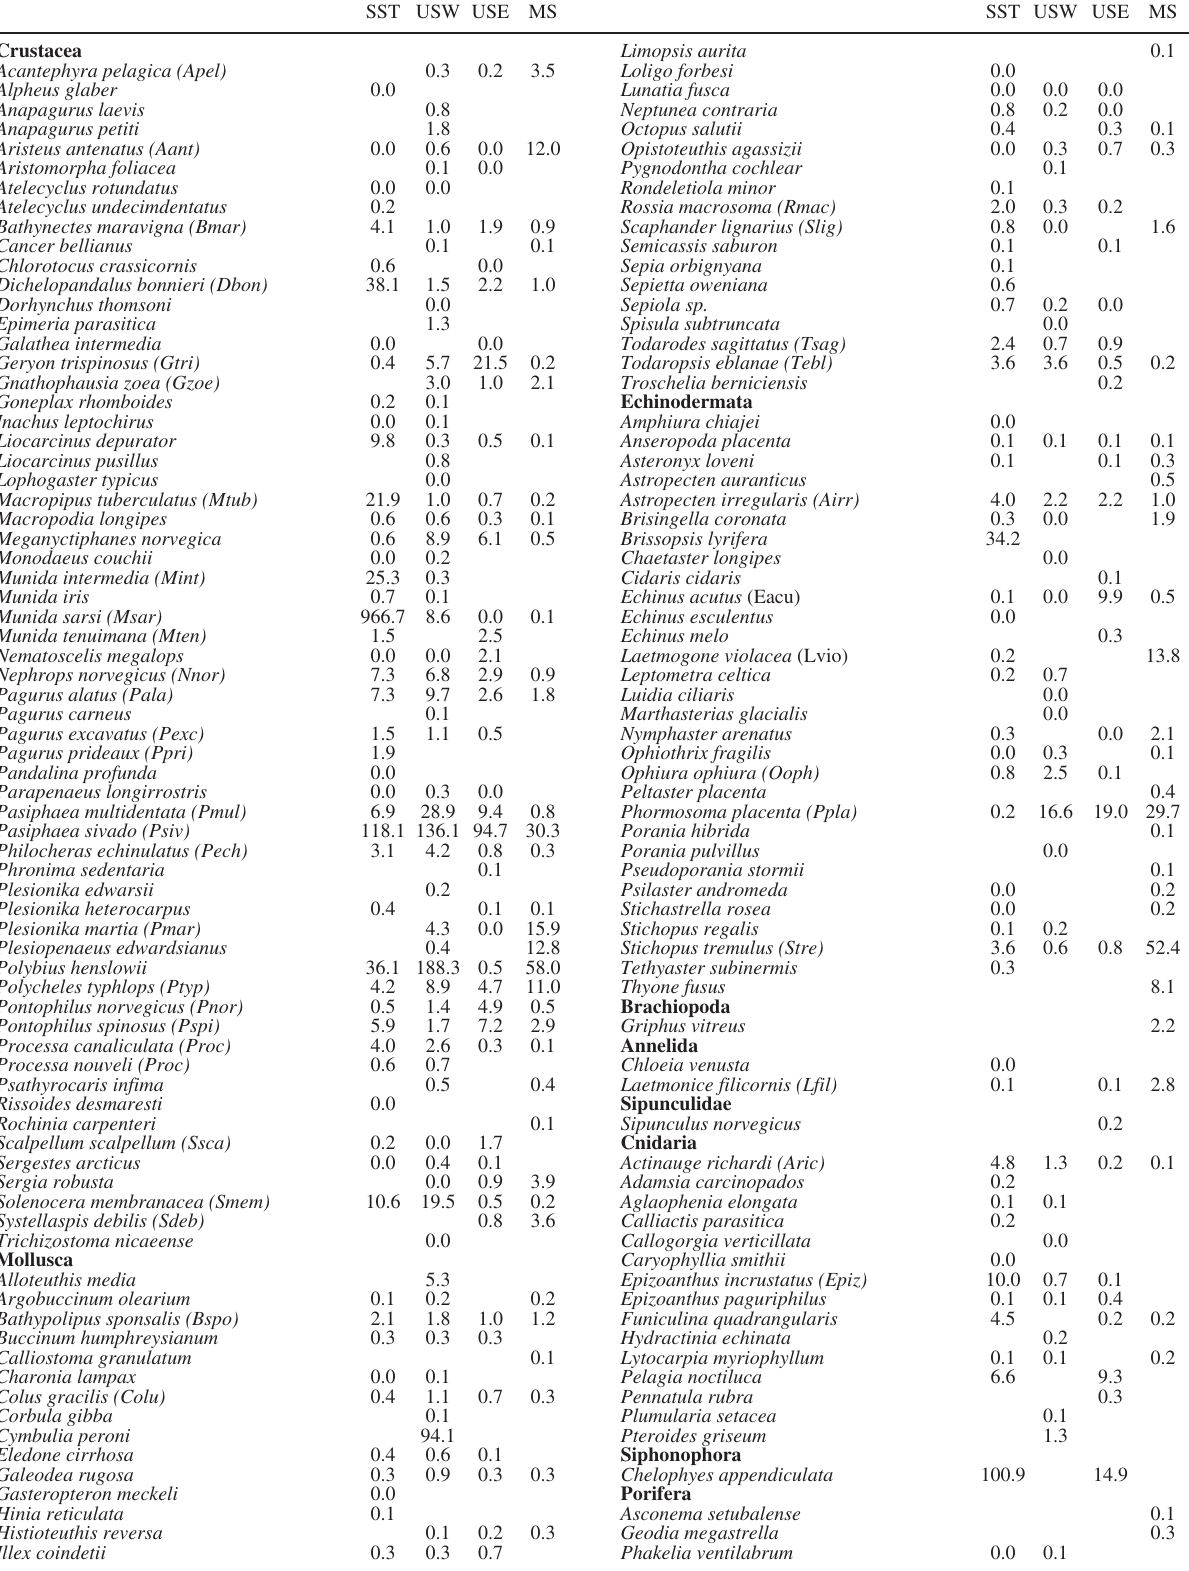
Table 2. – List of invertebrate species identified in the area. with their density (ind. ha –1 ) in each assemblage. Species codes used in Figure 3b appears between brackets after species name. in those species used in RDA analysis. 0.0 mean values >0 and <0.1. SST USW USE MS SST USW USE MS